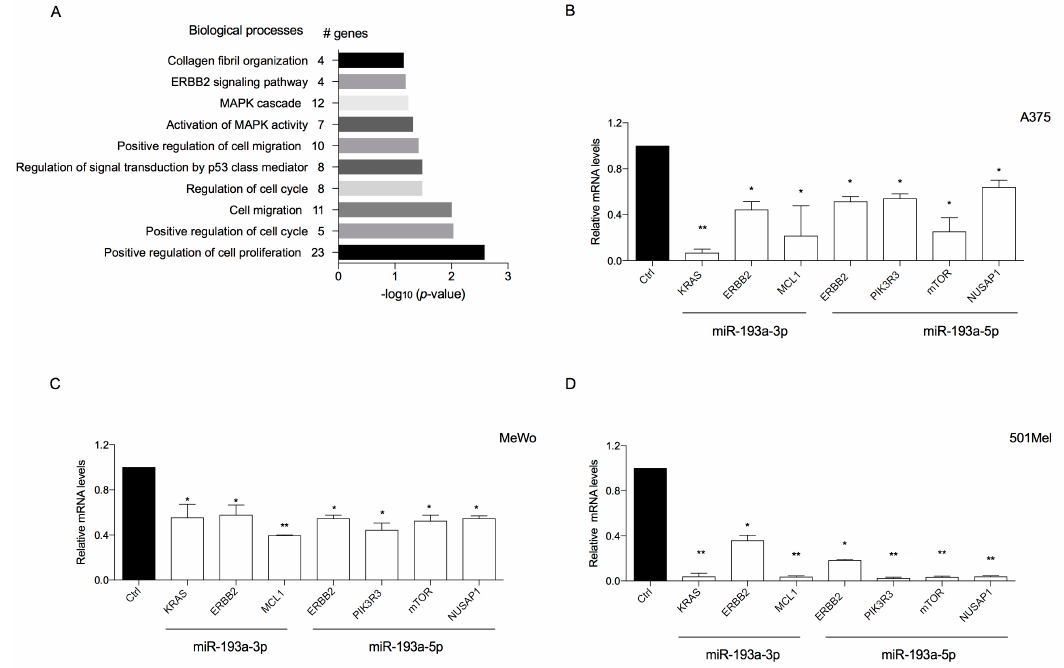
Figure 3. ( A ) Putative biological processes associated with target genes that can be negatively affected by ectopic over-expression of miR-193a-3p and -5p, as identified using DAVID analysis. ( B – D ) Ectopic over-expression of miR-193a arms reduces target genes in A375 ( B ), MeWo ( C ), and 501Mel ( D ). The expression of direct targets of miR-193a-3p (KRAS, EBBB2, and MCL1) or -5p (PIK3R3, MTOR, and NUSAP1) in melanoma cell lines following transfection with miR-193a-3p or -5p was measured by RT-qPCR. Data are normalized to β -actin and control mimic-transfected cells. Data are representative of three independent experiments ± SD performed in triplicate. Statistical analysis was performed using Student’s t -test (* p < 0.5, ** p < 0.01, compared to the corresponding control.)